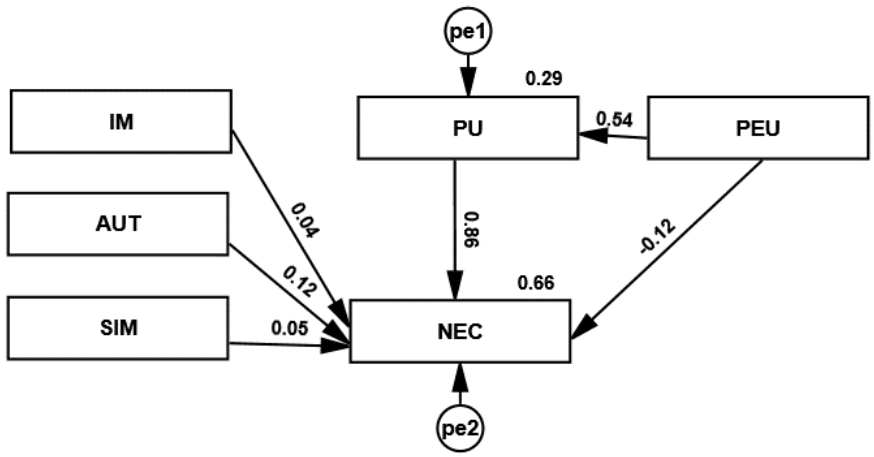
Figure 3. Structural model of the acceptance of remote medical advice technology. Source: Authors’ own research. Table 8. Standardized regression weights for the structural model.